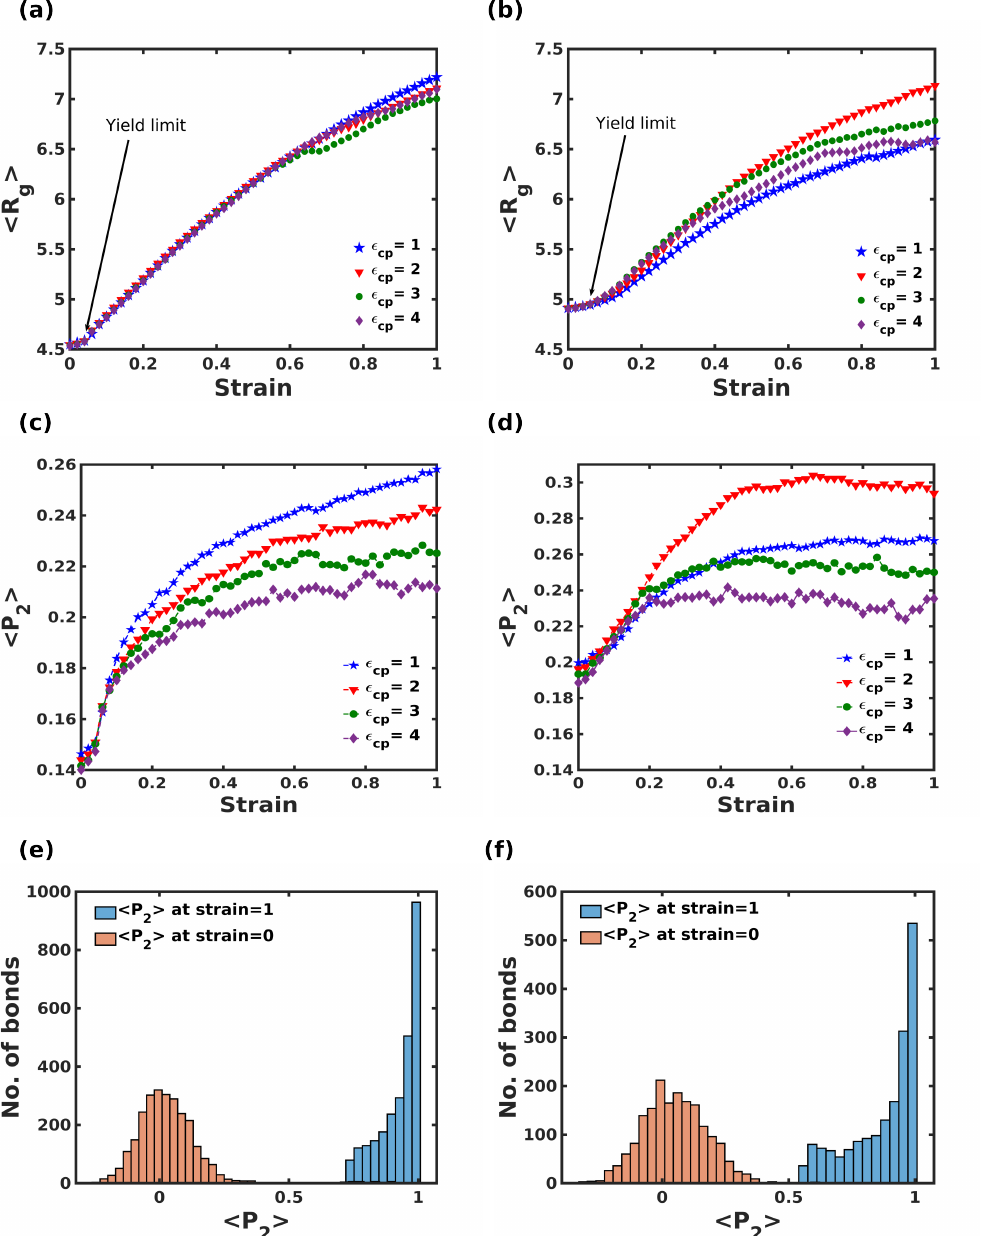
Figure 6. Mean radii of gyration < R g > and bond orientation parameter < P 2 > plot of ( a , c ) columnar, ( b , d ) staggered composite for different polymer-crystal interactions as a function of strain. ( e , f ) show the histograms of bond orientation parameter of polymer chains (20% of chains that underwent large inelastic extension) at strain = 0 (orange) and 1